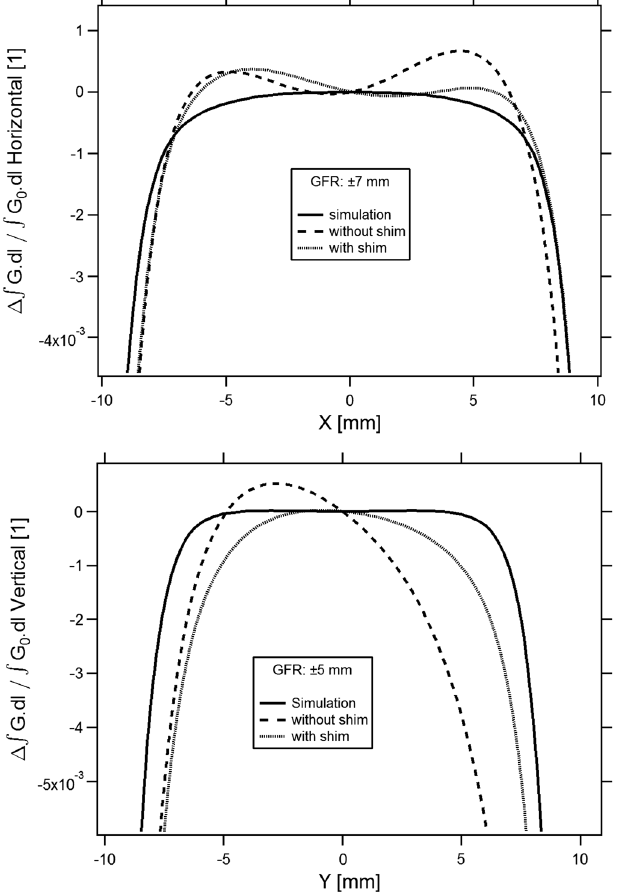
FIG. 12. Homogeneity of the integrated gradient along the horizontal and vertical axes. Simulation and measurement results are plotted. Results after correction shim implementation are